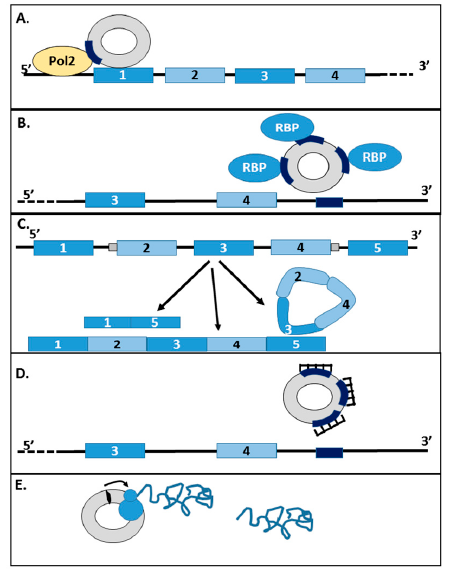
Figure 2 . Proposed roles of circRNA in the regulation of transcription and translation. circRNAs may regulate genes at several levels. ( A ) Firstly, nuclear circRNAs can interact with promoter regions of target genes and interact with RNA polymerase II (Pol2) to repress or enhance transcription; ( B )